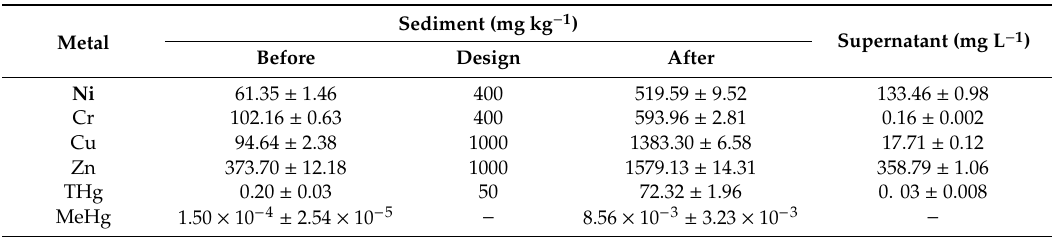
Table 5. Concentrations of the five metals in sediment before and after 60 days of incubation and the concentrations of the five metals in the supernatant after incubation.